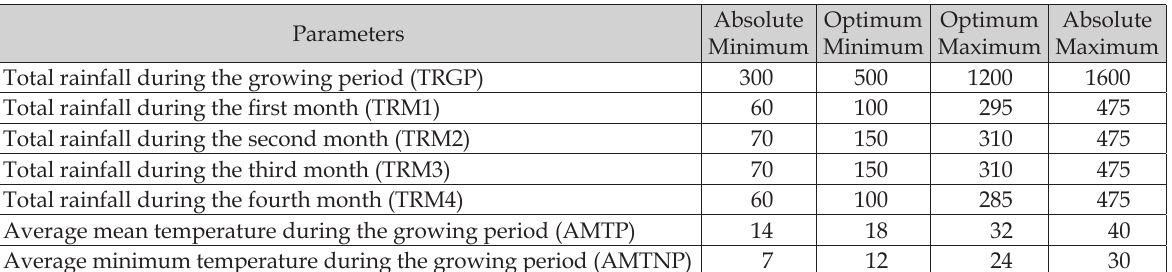
Table 1. Climatic parameters for corn suitability assessment adopted from Sys et al. (1993).